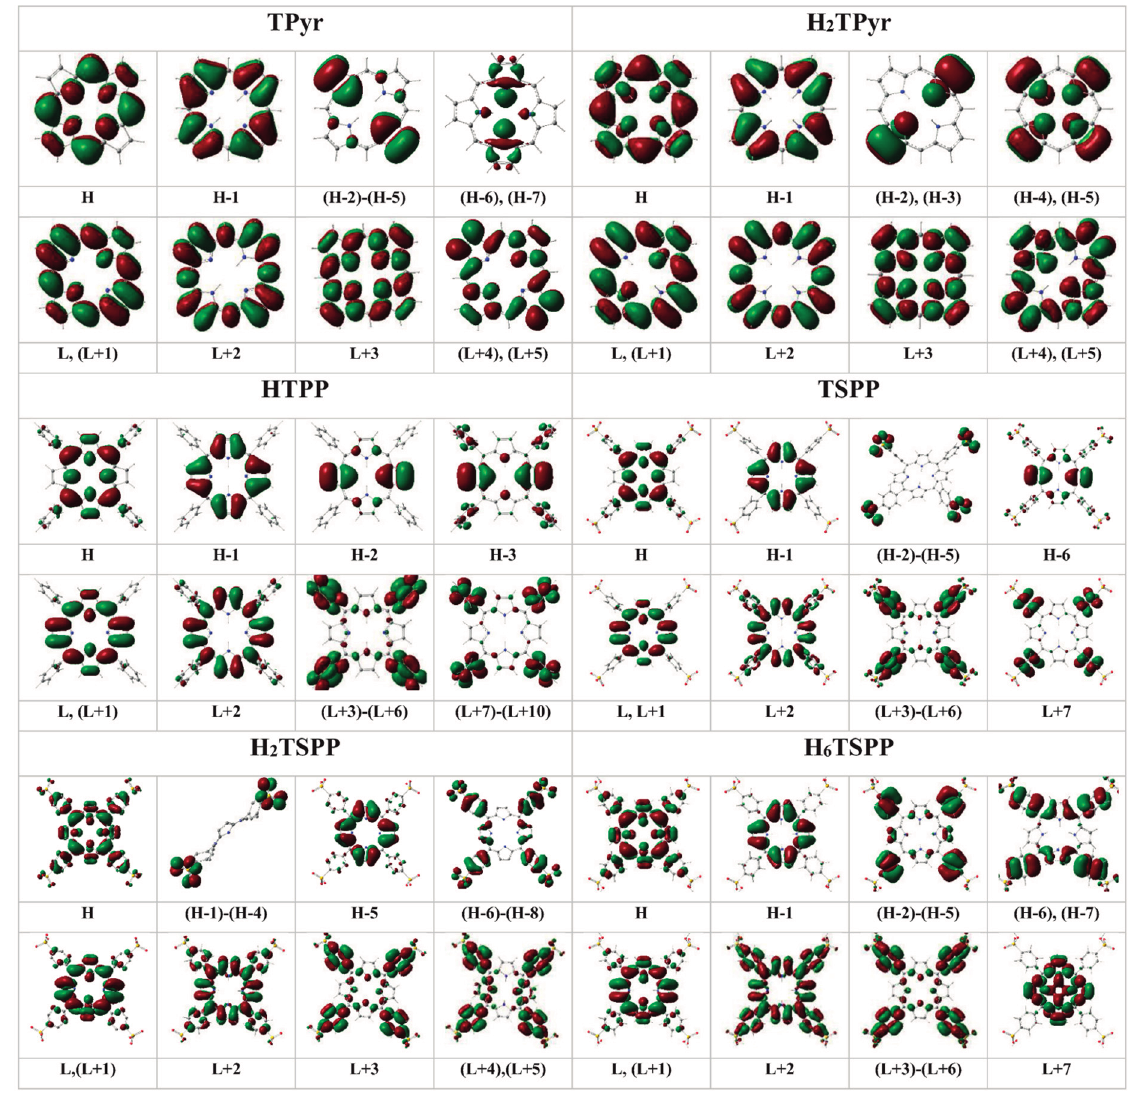
Figure 6. The plotted electron densities in the HOMOs (H) and LUMO (Ls) of: free-base porphyrin (TPyr), meso -tetraphenylporphyrin (TPP), dianionic meso-tetrakis( p - sulfonatophenyl)porphyrin (TSPP), and protonated-TPyr (H 2 TPyr),